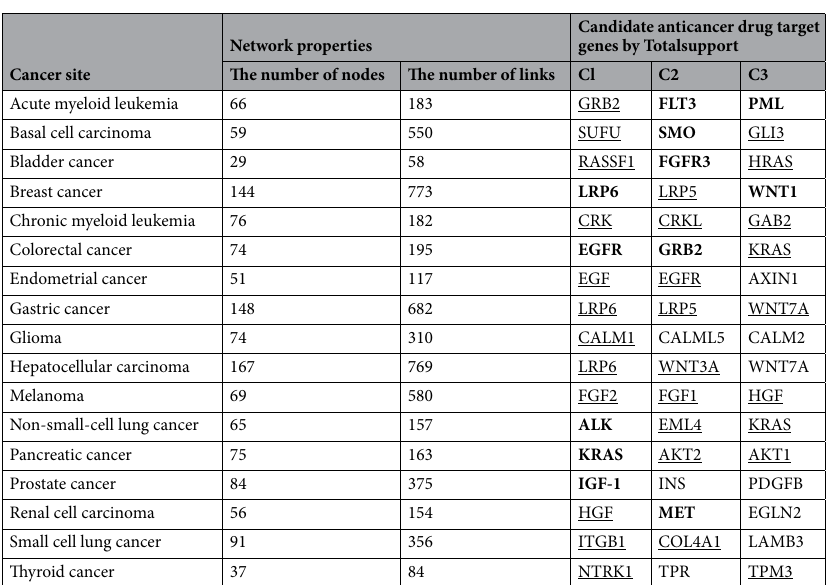
Table 1. Anticancer drug target genes are identified by total support ranking. In the table, C1, C2, and C3 denote NCBI gene symbols of the top three genes with the highest total support. The underlined and bold genes (42 out of 51) were previously reported as anticancer drug target genes (see Table S2), in which genes in bold are approved for drug manufacture whereas the remaining ones are clinical trial/potential. The remaining neither underlined nor bold genes in the top three highest-ranking genes that have not yet been fully investigated may be promising anticancer drug target